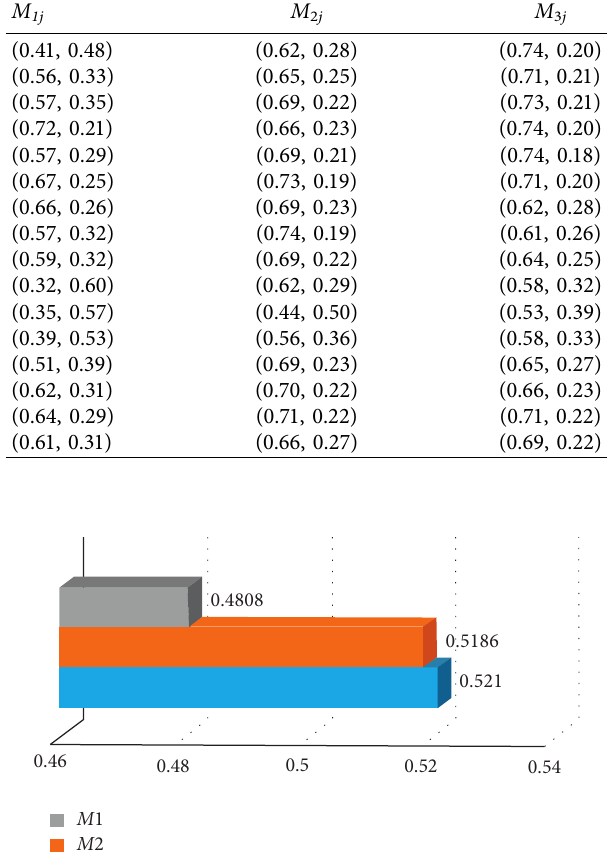
Table 4: Intuitionistic fuzzy evaluation matrix of the models.